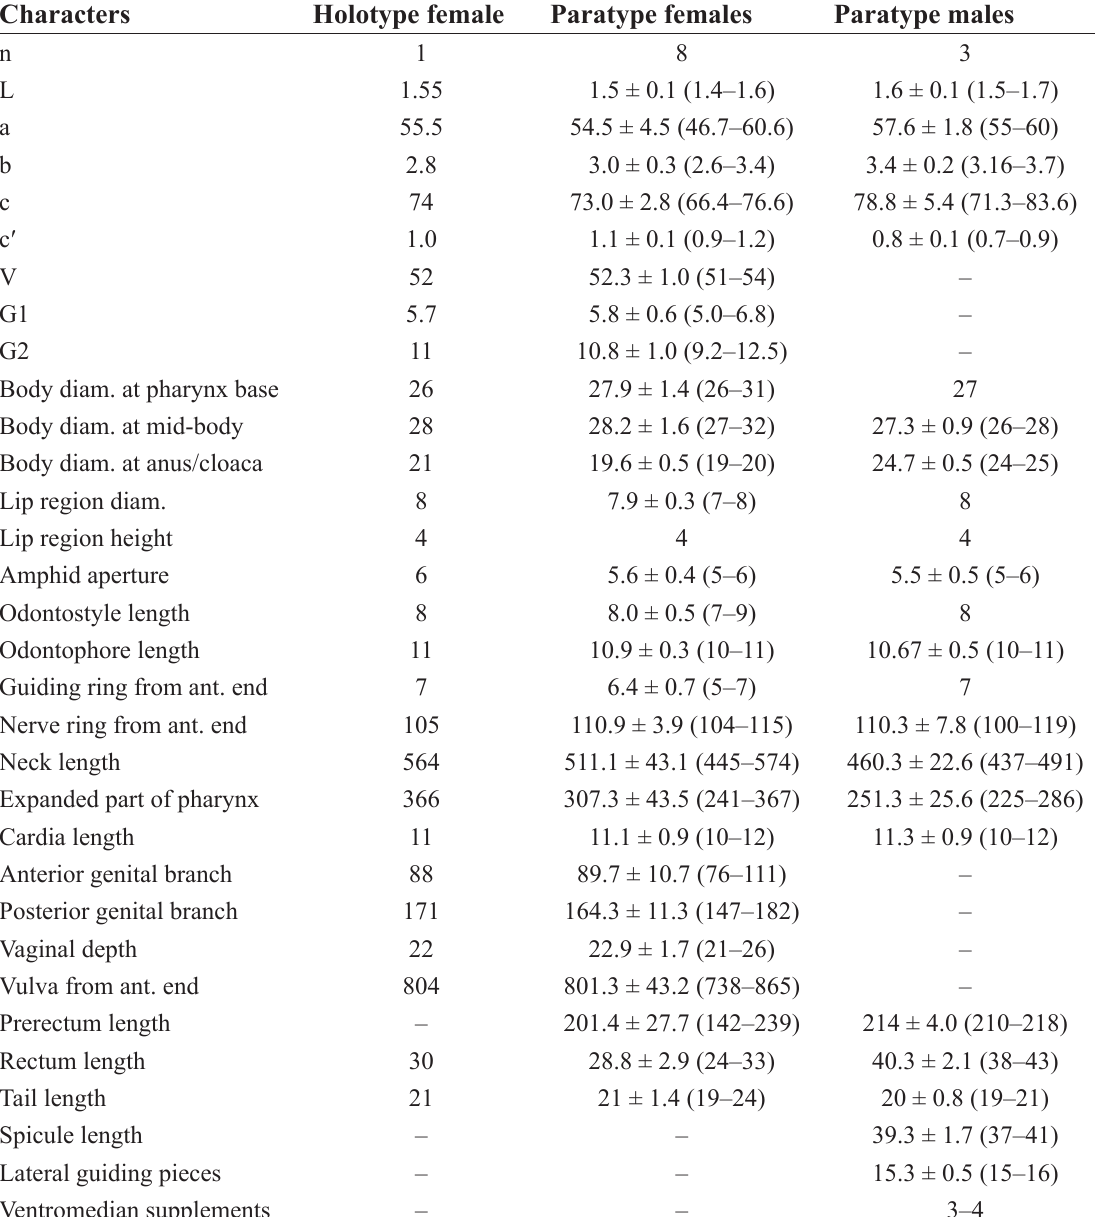
Table 7. Measurements of Axonchium nilgiriense sp. nov. All measurements in µm except L in mm, and in the form: mean ± s.d.